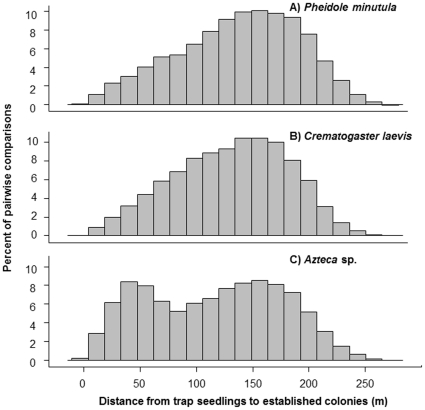
Pairwise distances from established colonies to trap plants.Histograms of the distance from trap plants to colonies for each of the three focal ant species. The X axis shows the percentage of all colony-trap pairwise comparisons. A) Pheidole minutula: mean colony-trap distance = 137.59 m±53.69 SD, B) Crematogaster laevis: mean colony-trap distance = 130.88 m±60.60 SD, C) Azteca sp.: mean colony-trap distance = 116.09 m±59.84 SD.